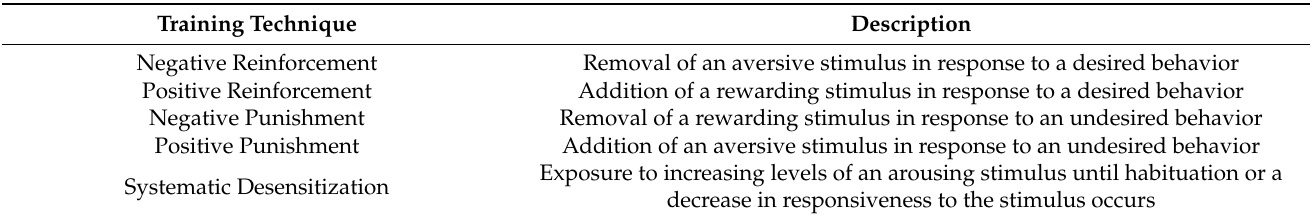
Table 2. Training techniques and corresponding descriptions respondents were asked to use in describing their horse training programs. Terms and descriptions are adapted from